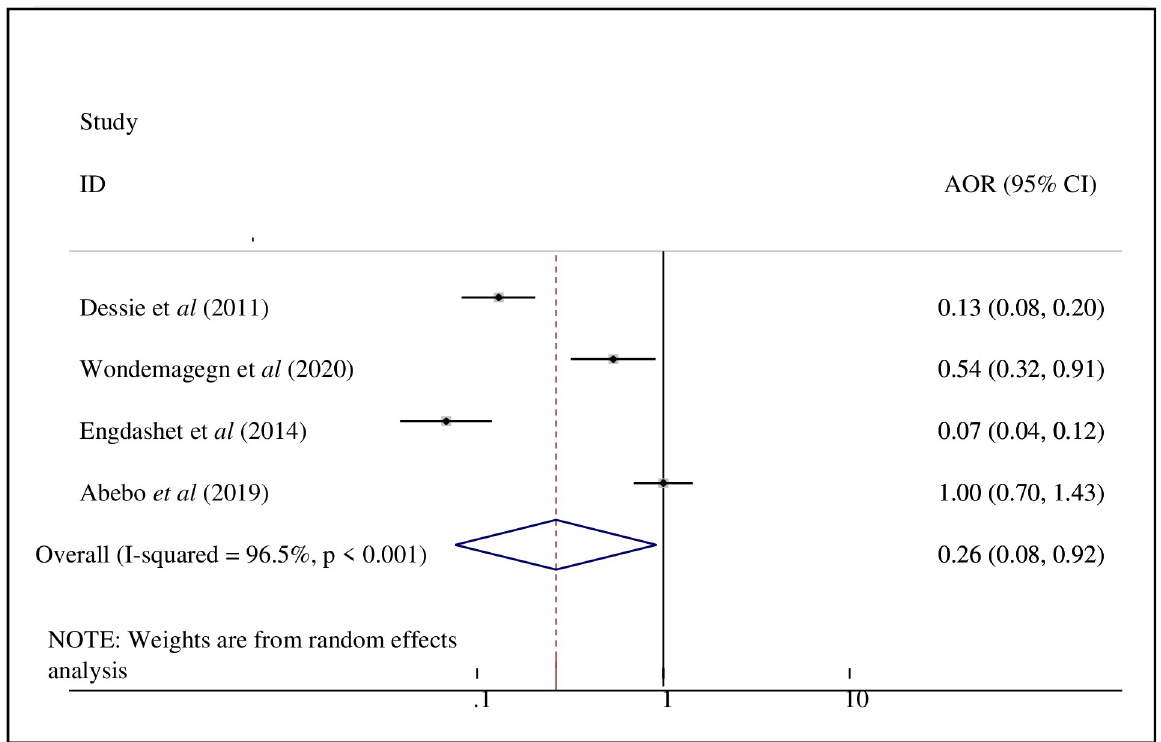
Fig 7. Forest plot of the association between discussion about safe sex with partner/s and risky sexual practice in Ethiopia.